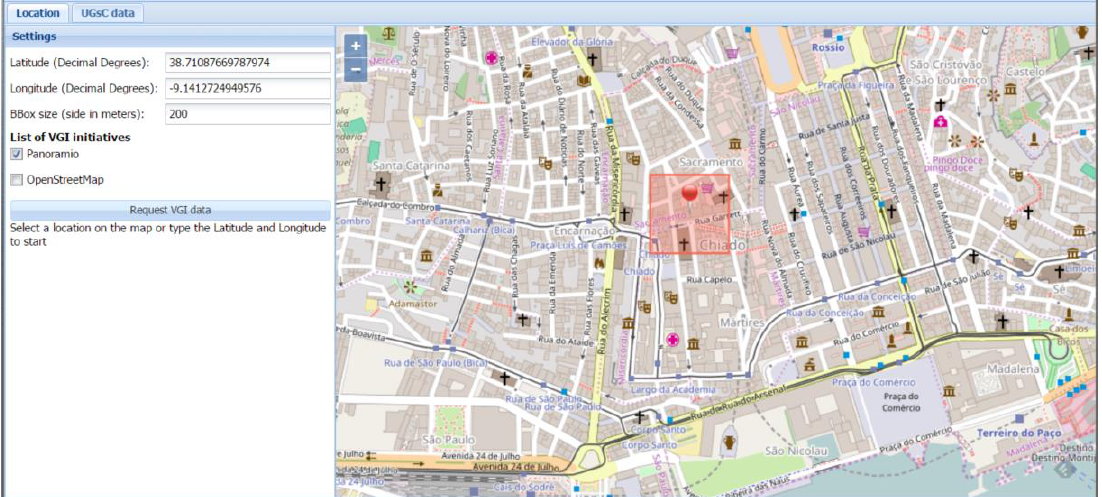
Figure 4. Initial interface for the photo interpretation use case (note: the pin and square represent, respectively, the selected location and the bounding box used in requesting data from the initiatives).